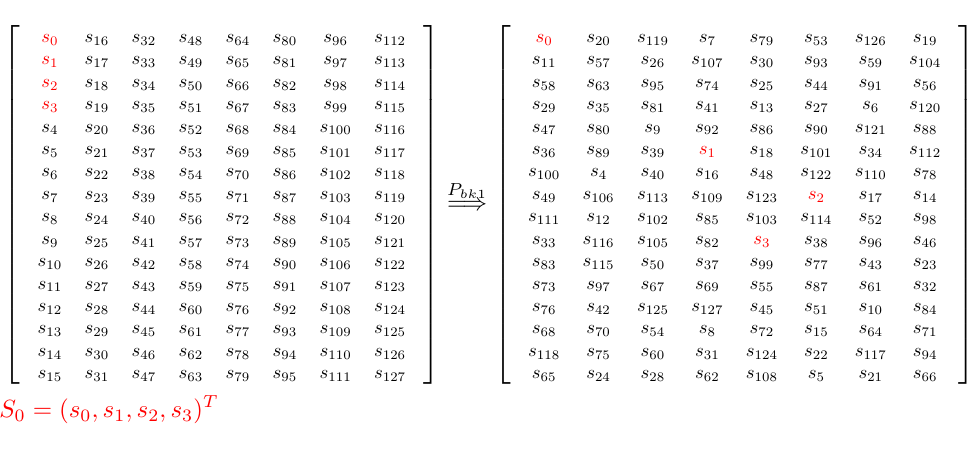
Figure 11: The 4 active bits after the bit permutation in the first round, as marked in red.